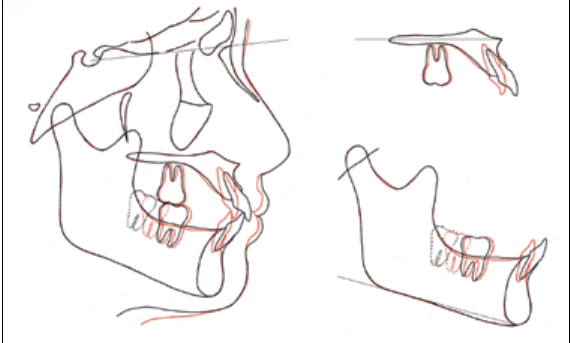
Figure 13. Superimpositions of pretreatment (black line) and post- treatment (red line) lateral cephalometric tracings. Broken line: pretreatment (black) and post-treatment (red) mandibular left second